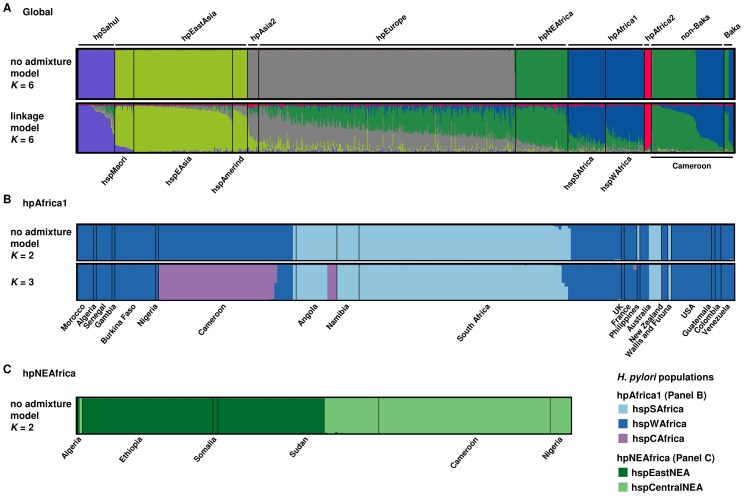
Bayesian population assignments using STRUCTURE 2.0.(A) DISTRUCT plot of the population assignment of Cameroonian H. pylori haplotypes in a global reference dataset as determined by the “no admixture model” (K = 6) and the “linkage model” (K = 6). Each bacterial isolate is depicted by a thin vertical line, which is divided into K colored segments representing the membership coefficients in each cluster. Black lines separate isolates of different populations/subpopulations. Populations are labeled above the figure, subpopulations below the figure. Cameroonian non-Baka and Baka H. pylori haplotypes are shown on the right side of the plot. (B) DISTRUCT plots of the subpopulation assignment of H. pylori hpAfrica1 haplotypes using the “no admixture model” (K = 2, K = 3). Strains were grouped together according to their geographical source. (C) DISTRUCT plot of the population structure of H. pylori hpNEAfrica haplotypes according to the “no admixture model” (K = 2). Strains were grouped together according to their geographical source.